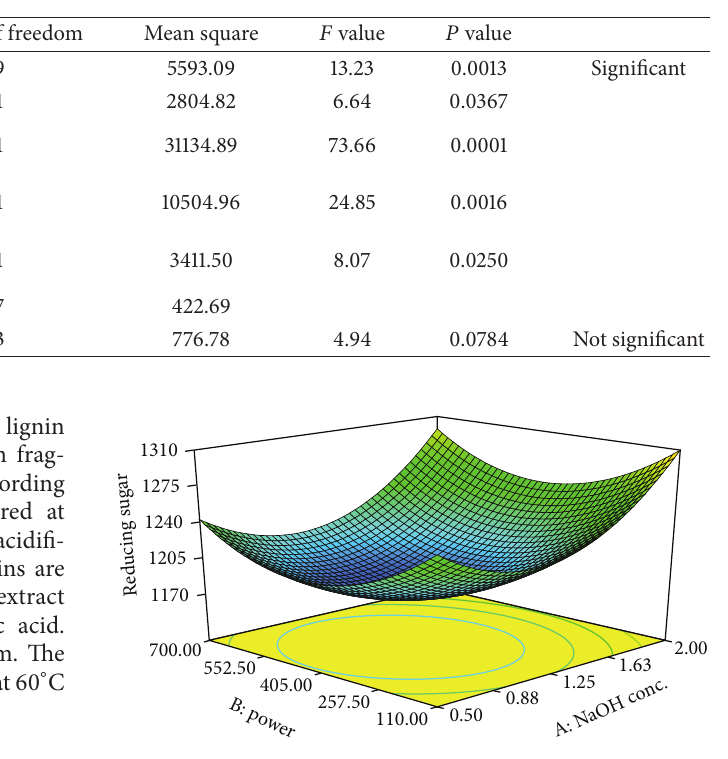
Figure 1: Response surface for the effect on reducing sugar using power (microwave) and NaOH concentration at constant